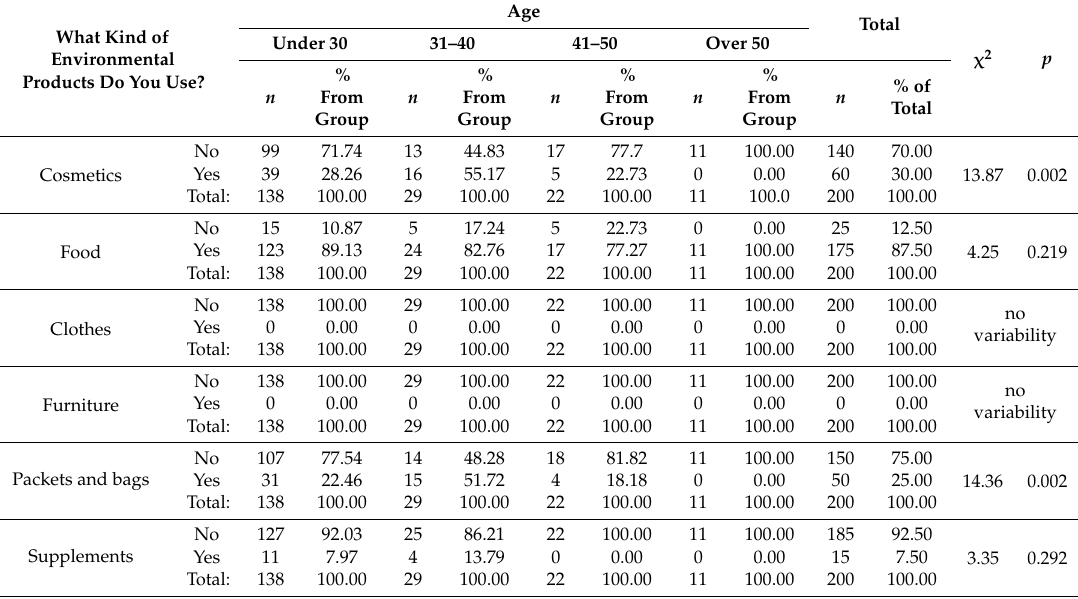
Table 7. Age vs. using specific environmental goods— χ 2 independence